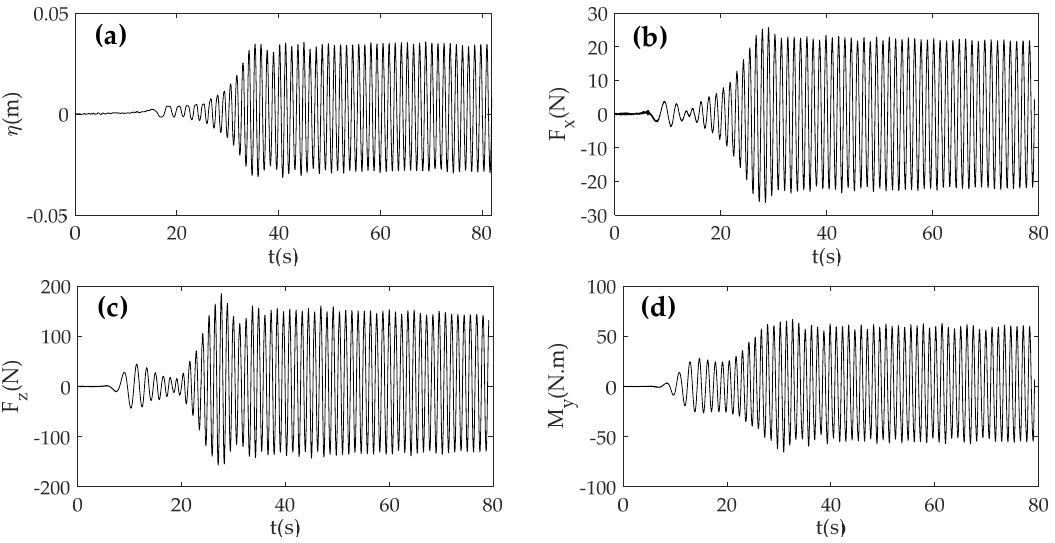
1 BF indicates regular wave cases on a flat bottom and BS indicates cases on a sloped bottom.